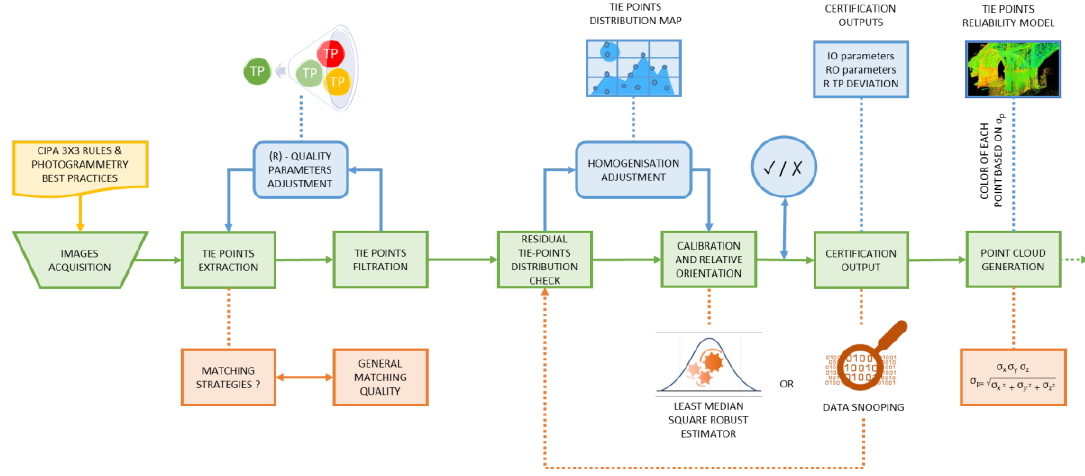
Figure 1. The pipeline of the proposed operative